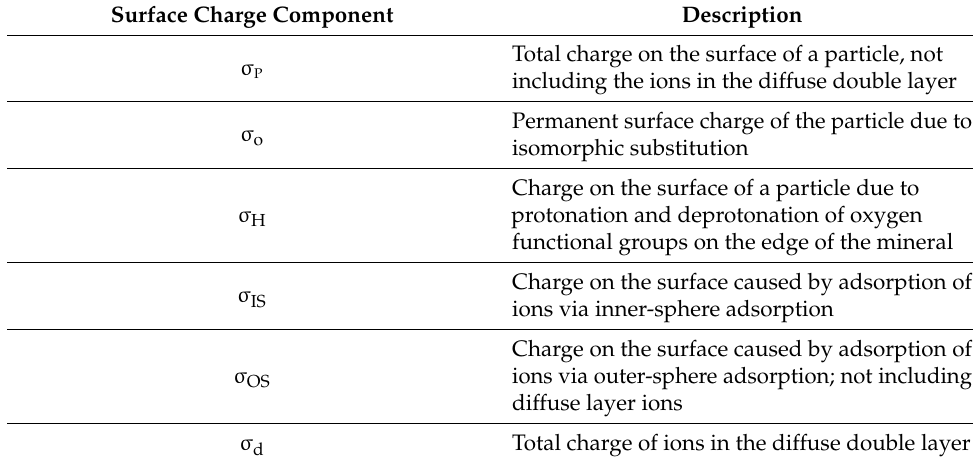
Table 3. Surface charge components of soil